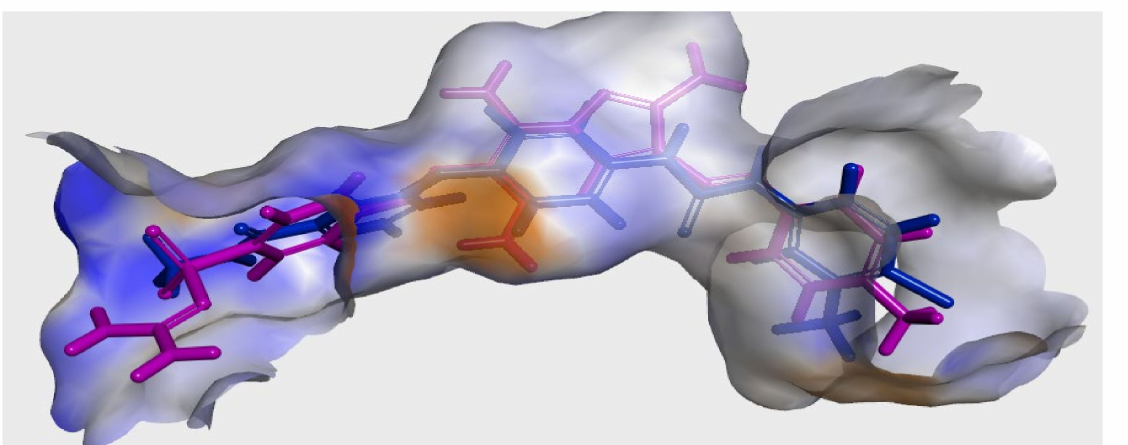
Figure 9. Alignment of compound 7 ( purple ) and sorafenib ( blue ) inside the ATP binding site of VEGFR2 kinase.